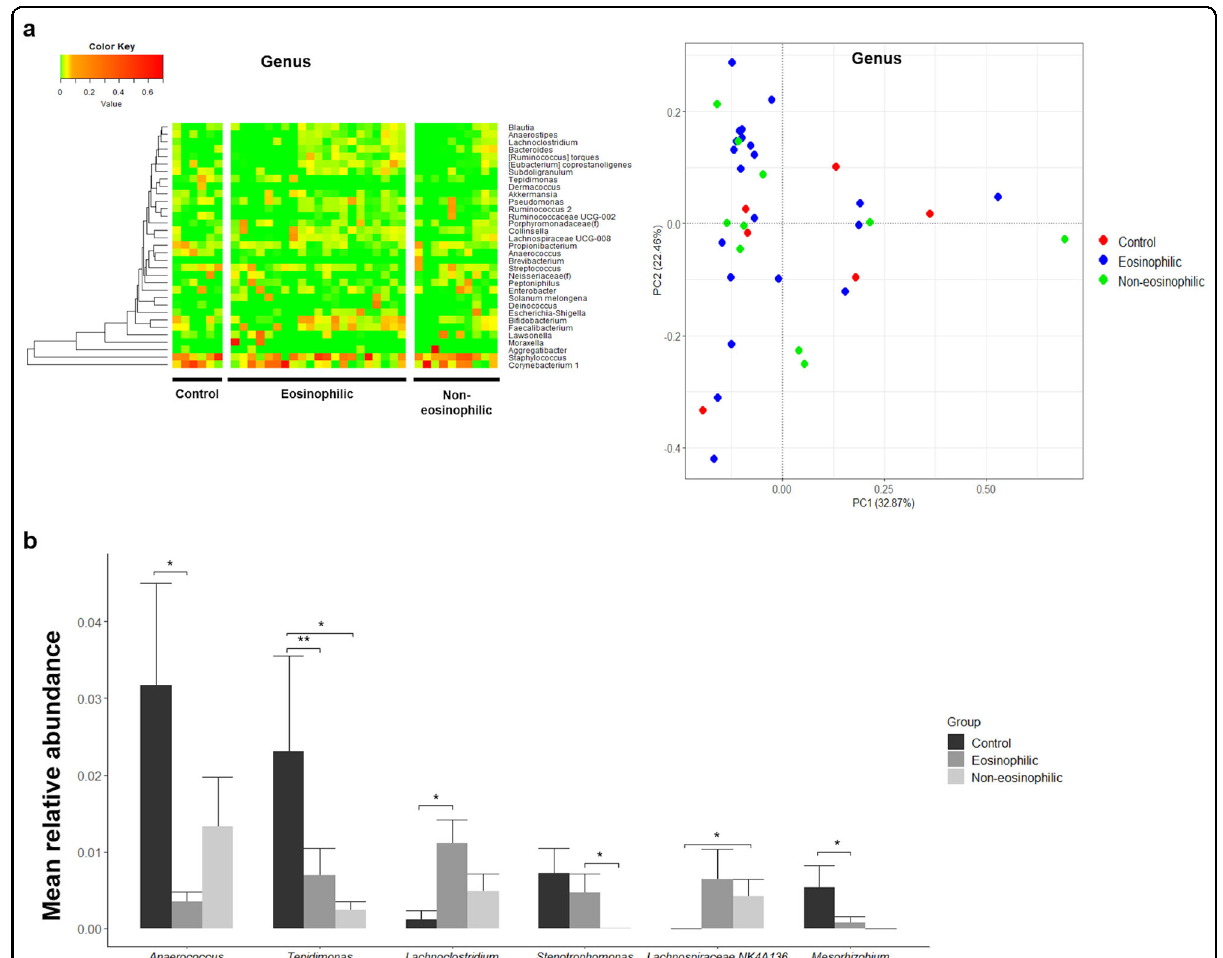
Fig. 1 Signi fi cantly differentially abundant bacterial genera in the sinus among control subjects, patients with eosinophilic chronic rhinosinusitis with nasal polyps, and patients with noneosinophilic chronic rhinosinusitis with nasal polyps. a Differences in the composition of sinus bacteria between the three groups were identi fi ed by a heat map, although there was distinct clustering on the PCoA plot. b In patients with eosinophilic chronic rhinosinusitis with nasal polyps, the RAs of Anaerococcus , Tepidimonas , and Mesorhizobium were signi fi cantly decreased, whereas that of Lachnoclostridium was signi fi cantly increased compared with those in controls. * P < 0.05, ** P <